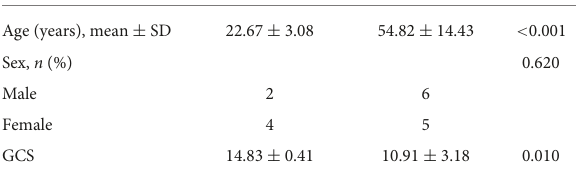
TABLE 2 Clinical data of patients with and without TBI.